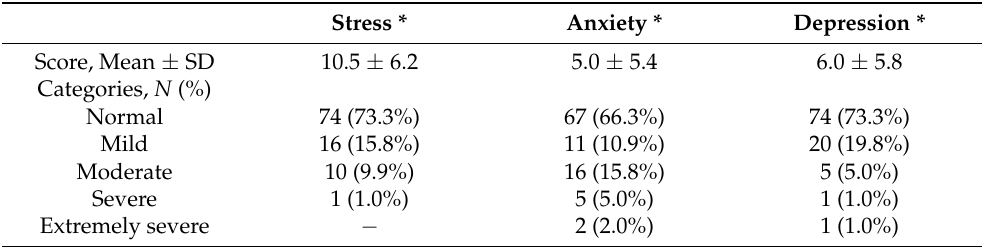
Table 4. Participants’ performance on the three subscales of the Depression, Anxiety, and Stress Scale—21 Items